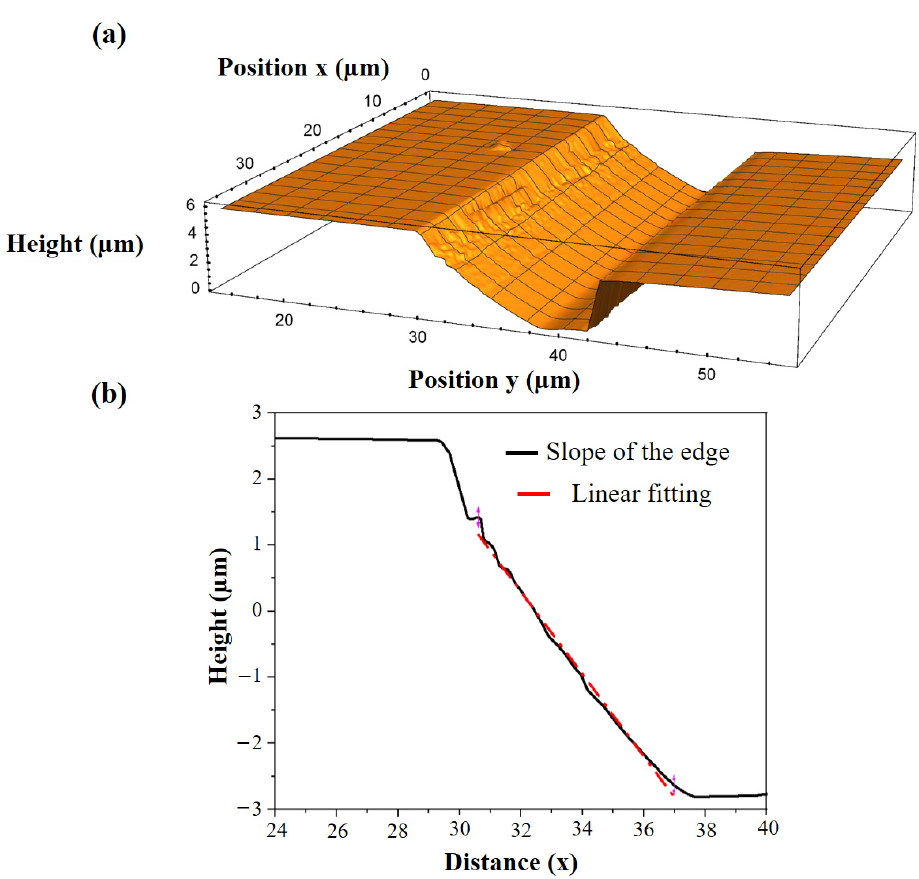
Figure 12. ( a ) 3D optical profile of the emitter edge along with the deflecting mirror and vertical mirror. ( b ) A single scan from this 3D profile along the tilted edge of the proposed 45° deflecting mirror shows the corresponding angle of 29°.